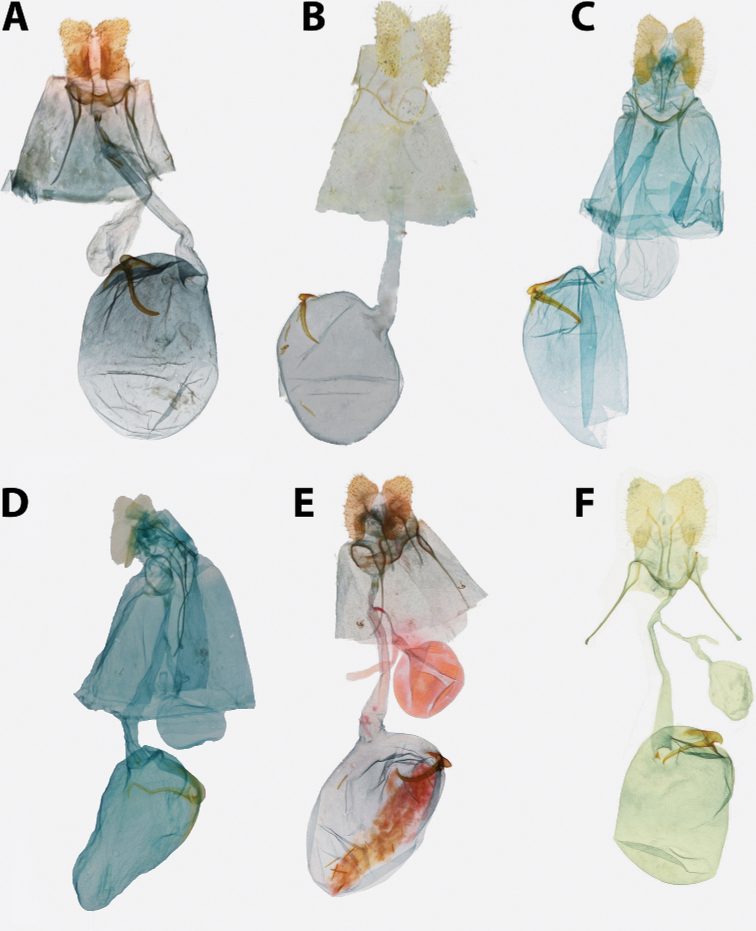
Argyrotaenia female genitalia. Not to scale. AA.
jamaicana, Jamaica. KAA diss. #0127 (USNM) BA.
vinalesiae, Cuba. KAA diss. #0159 (VBC) CA.
razowskiana sp. nov. paratype, Dominican Republic. KAA diss. #0106 (CMNH) DA.
paradisei sp. nov. paratype, Dominican Republic. KAA diss. #0073 (CUIC) EA.
cryptica
cryptica ssp. nov. paratype, Dominican Republic. KAA diss. #0171 (CMNH) FA.
cryptica
praeteritana ssp. nov. paratype, Dominican Republic. Razowski diss. #10733 (CMNH).